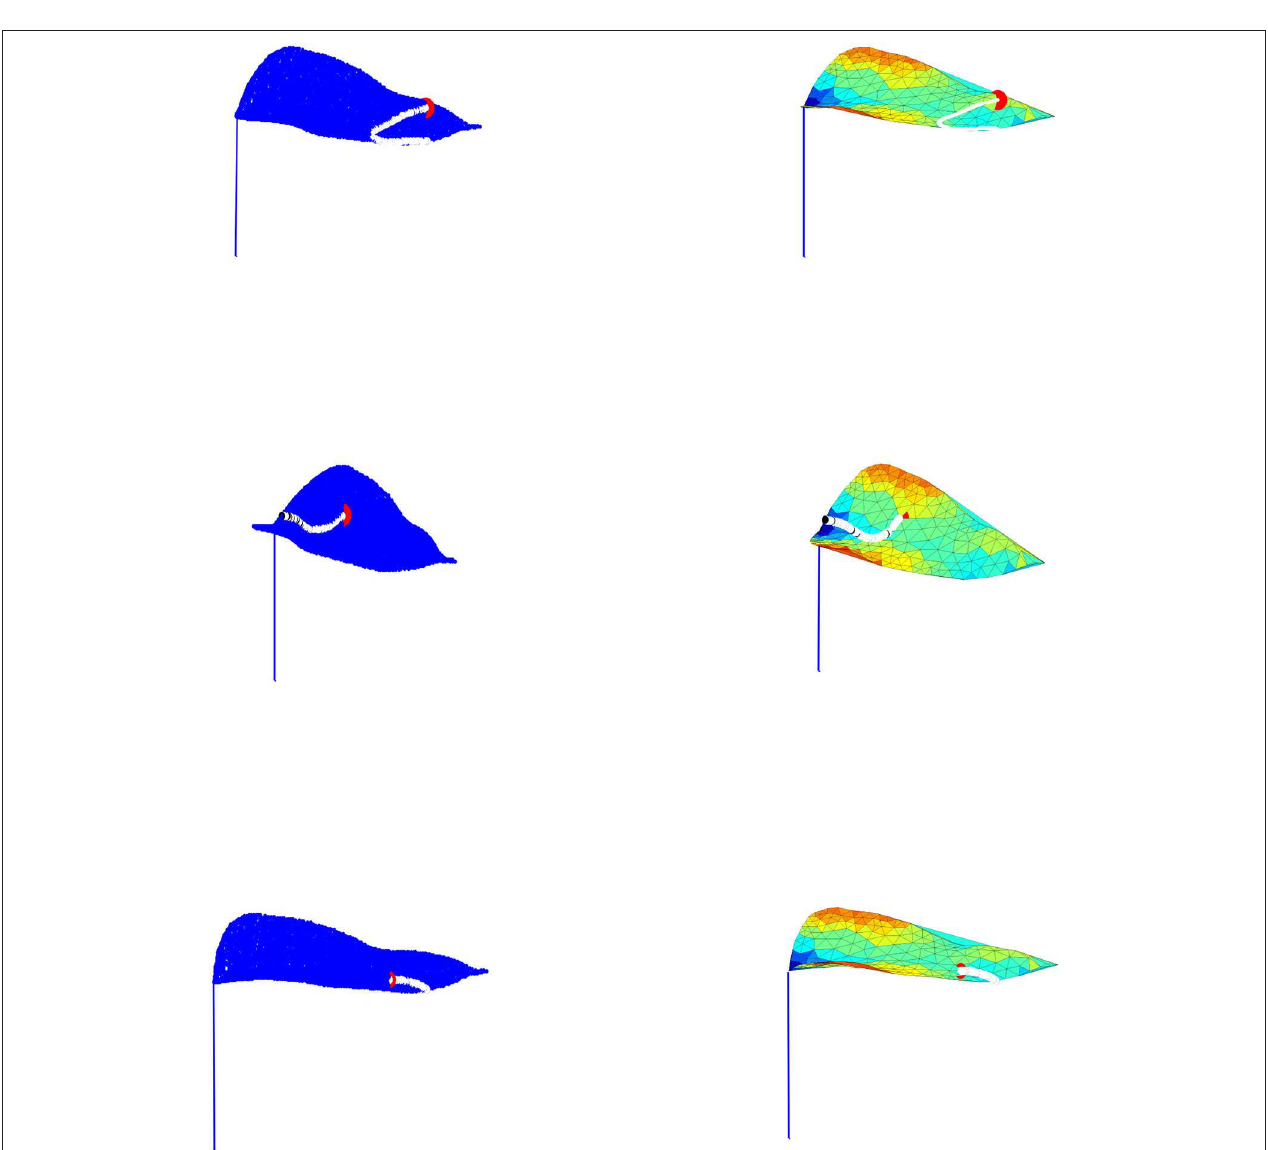
FIGURE 6 | The figures given on the left column represent the droplet motion using our model across the constructed leaf, while the figures given on the right column show the corresponding droplet movement on the leaf triangulation.